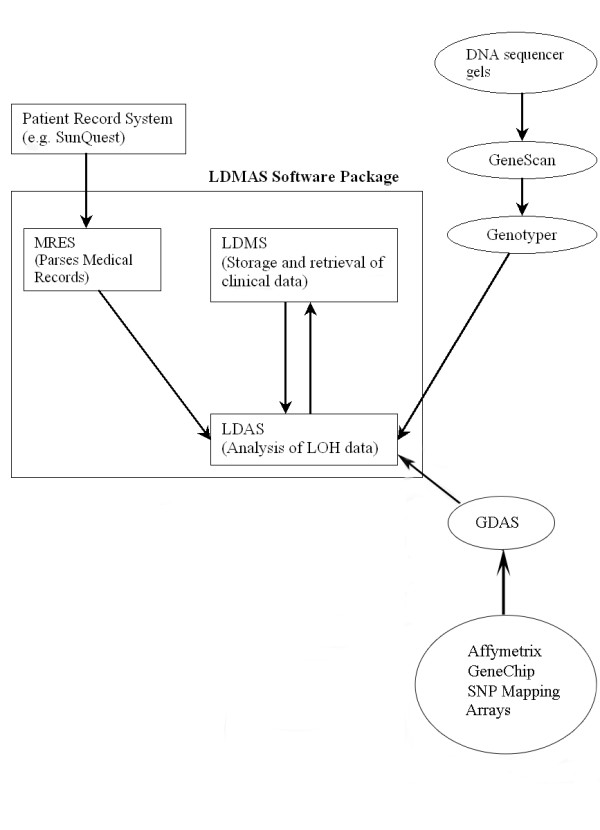
LDMAS architecture.